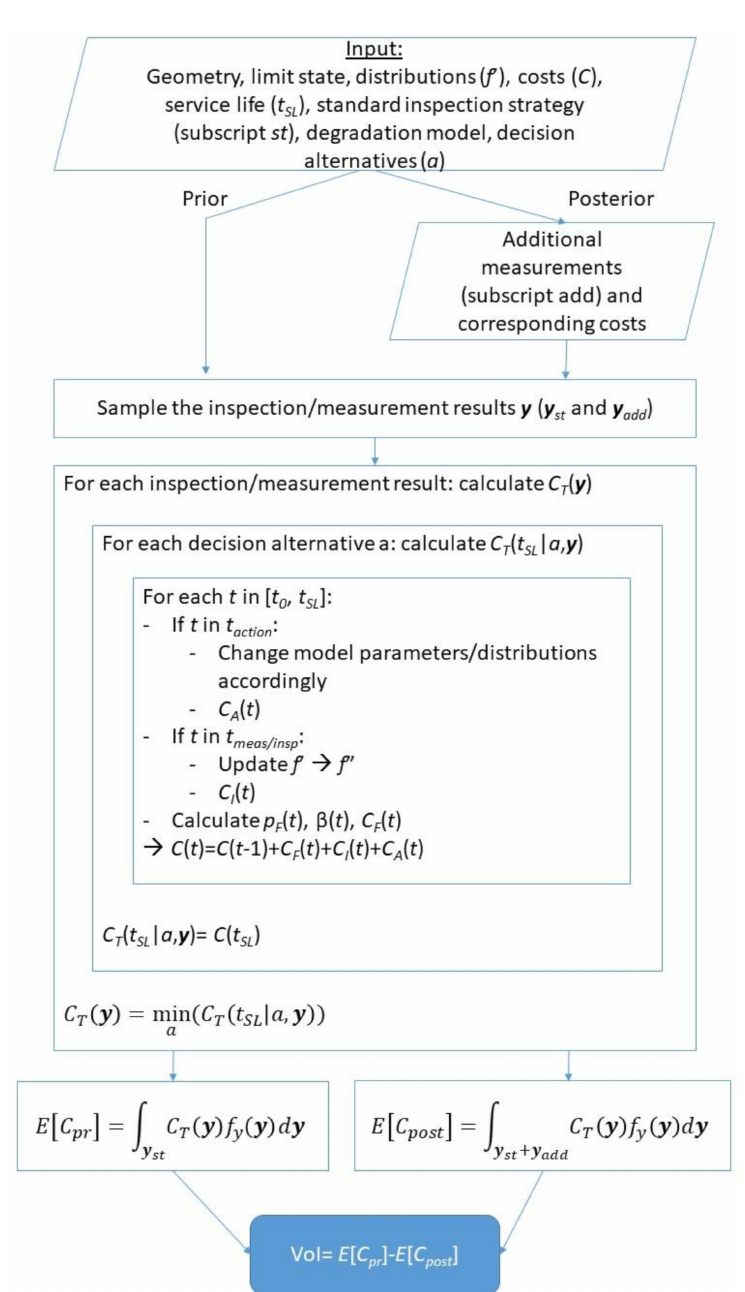
Figure 1. General framework for the calculation of the